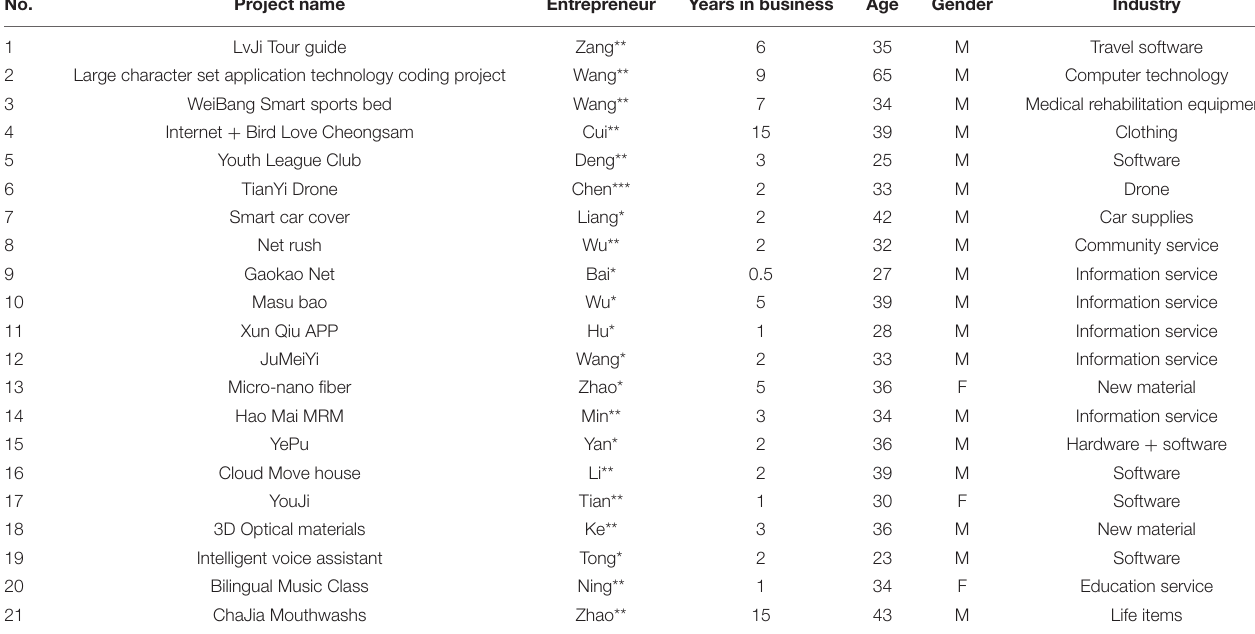
TABLE 6 | Case samples of Study